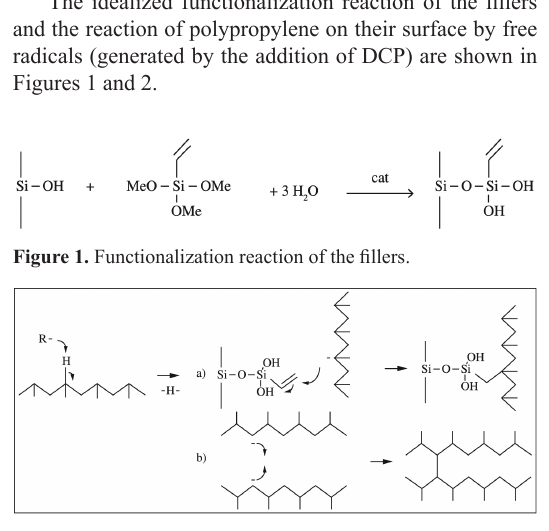
Figure 2. Reaction of grafting the polypropylene chain on the surface of the filler through the vinyl group of fixed VTMS (a). Crosslinking reaction of PP by radicals can also occur